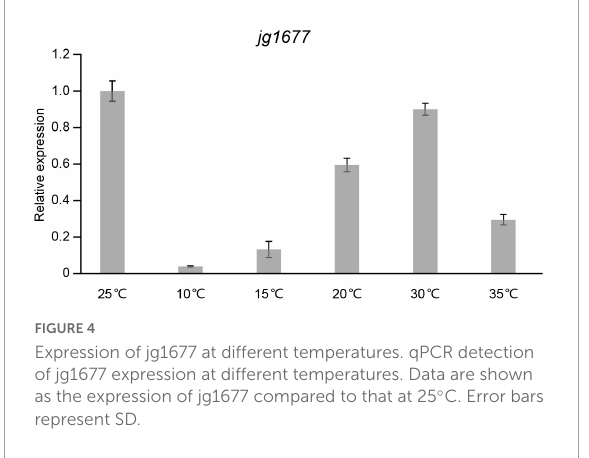
FIGURE6 Expression levels of jg1677 of samples collected in plastic bags for different times at room temperature. qPCR detection of jg1677 expression for different sealing times. Data are shown as the expression of jg1677 compared to control. Error bars represent